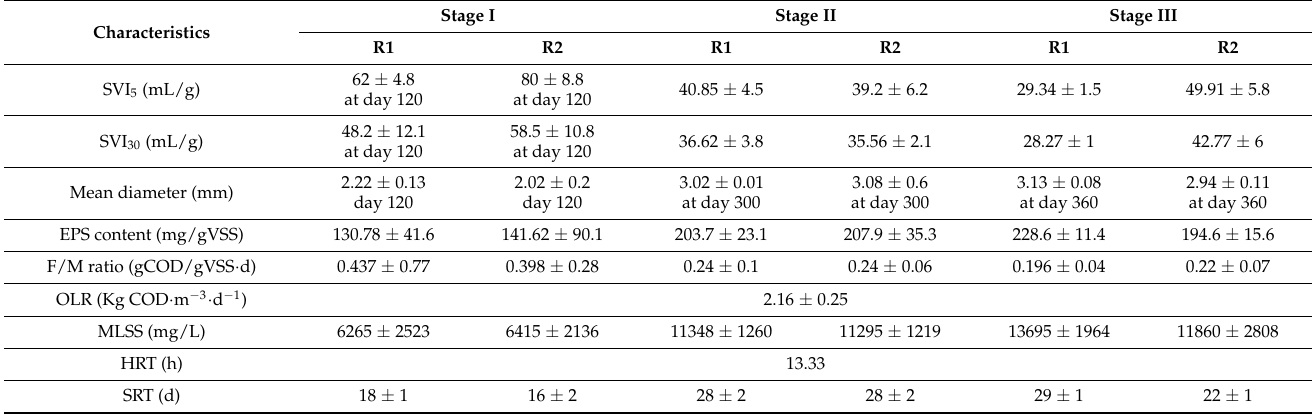
Figure 2. Stability and characteristics of AGS over the entire operational period for ( a ) R1 and ( b ) R2. Table 3. AGS characteristics (mean values) throughout the operational period for R1 and